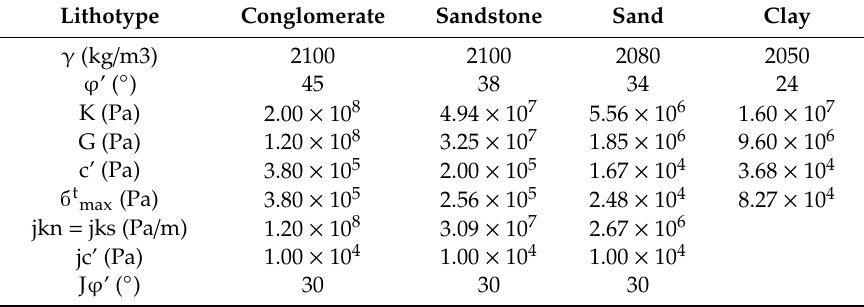
Table 1. Physical mechanical parameters of the lithotypes. Legend: γ volume weight (kg / m 3 ); ϕ ’ internal friction angle ( ◦ ); c’ apparent cohesion (Pa); K bulk modulus (Pa); G shear modulus (Pa); and / tan ϕ ’) b t max tension strength (c’